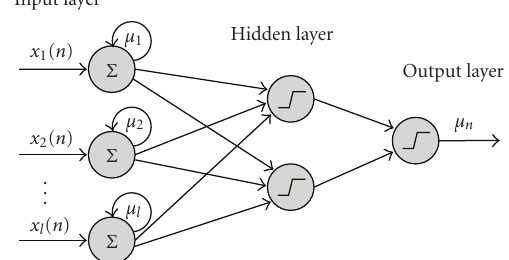
Figure 3: Variation of average of minimum MSE for 5 runs versus number of PEs in the second hidden layer.